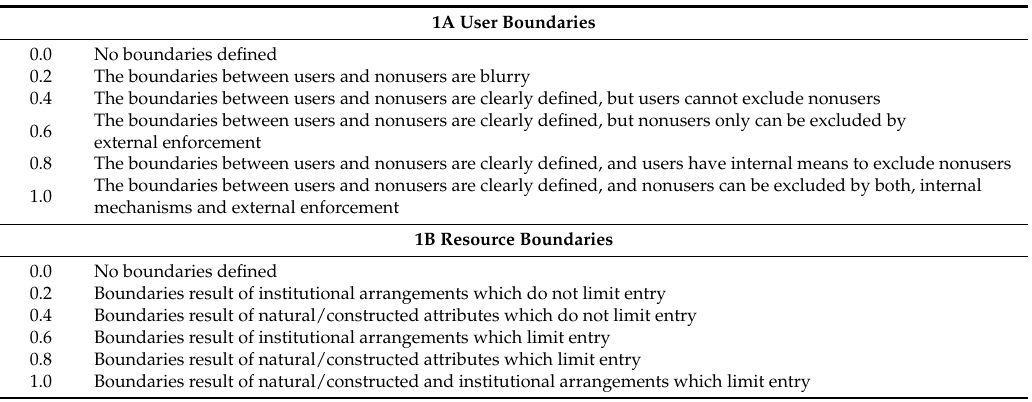
Table 2. Categories of membership score for each